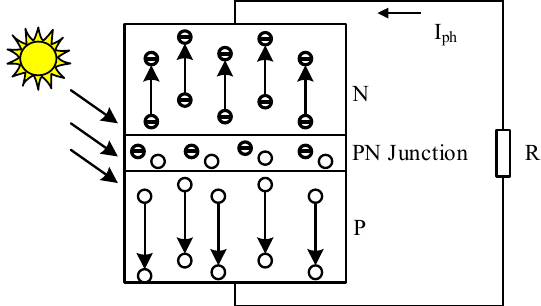
Figure 1. Photovoltaic effect principle.